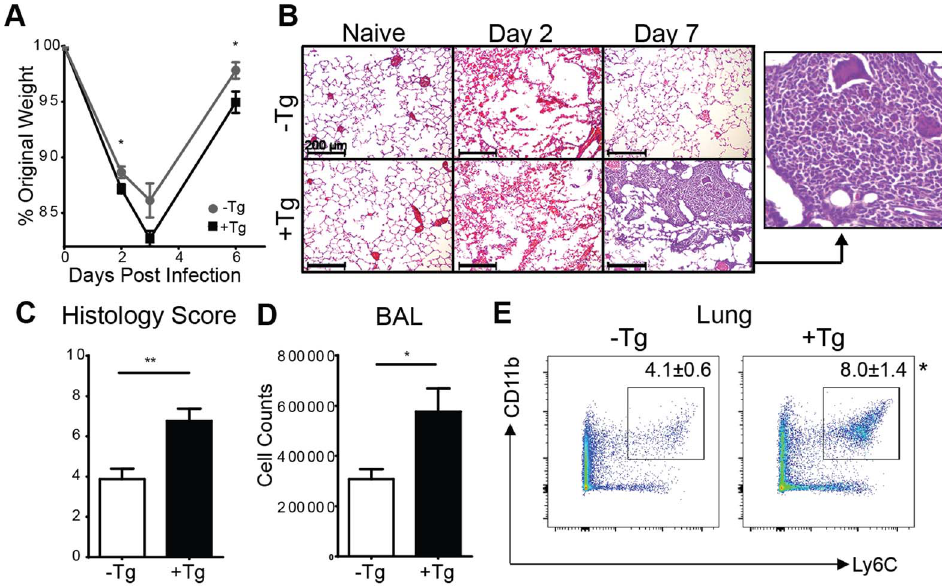
Fig. 3. Expression of hResistin exacerbates lung inflammation. (A) h Retn Tg 2 mice or h Retn Tg + mice were infected with Nb and weight loss was measured as a percentage of original weight. (B-C) Lung sections from naı¨ve or Nb -infected mice were stained with H&E (B, scale bar =200 m m) and pathology at day 7 post-infection was assessed by blind scoring (C). (D-E) At day 7 post infection, total BAL cells were quantified (D) and dissociated lung cells were recovered for flow cytometry analysis of Ly6C + CD11b + monocytes (E). Data (mean 6 SEM, n=4–6 per group) are representative of three separate experiments.